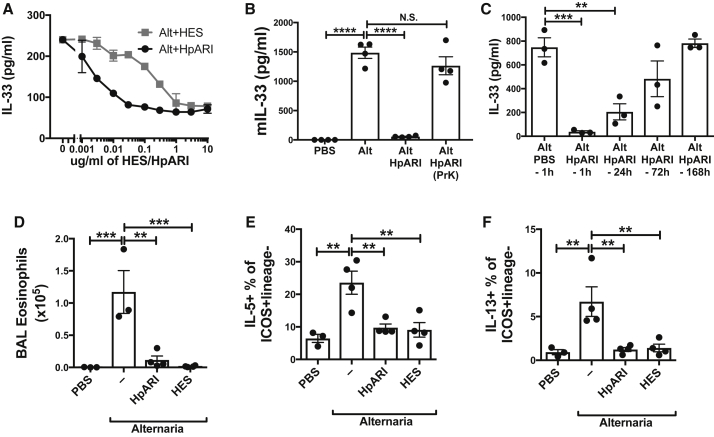
HpARI Suppresses Responses to Alternaria Allergen(A) IL-33 levels (ELISA) in supernatants of naive mouse lung cells, cultured for 1 hr in the presence of Alternaria (200 μg/ml) and HES or HpARI.(B) IL-33 levels (ELISA) in BAL 1 hr after Alternaria allergen administration with HpARI (5 μg) or proteinase K-degraded and heat-treated HpARI (“HpARI (prK)”).(C) IL-33 levels (ELISA) in BAL 1 hr after Alternaria allergen administration, with HpARI (5 μg) administered 1, 24, 72, or 168 hr prior to Alternaria allergen.(D) BAL eosinophil numbers 24 hr after Alternaria allergen, HpARI, and HES administration.(E) Lung ILC2 IL-5 staining from mice in (D).(F) Lung ILC2 IL-13 staining from mice in (D).All data representative of 2–3 repeat experiments, each with 3–4 replicates/mice per group. Error bars show SEM.